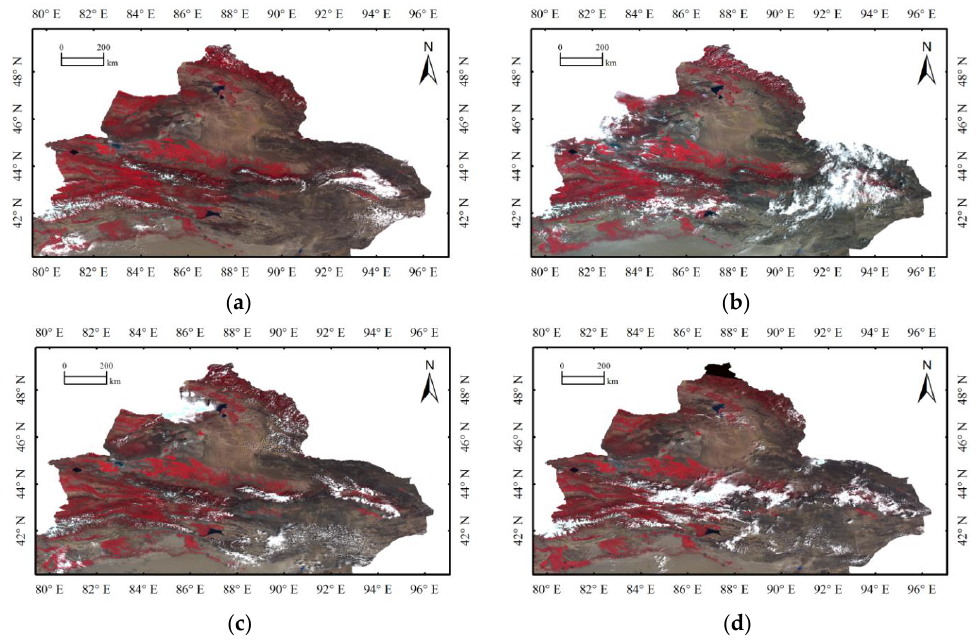
Figure 5. MODIS false-color images for the northern Xinjiang area (R, G, B = 2, 1, 4). ( a ): 11 July 2014; ( b ): 15 July 2014; ( c ): 12 August 2014; ( d ): 21 August 2014.